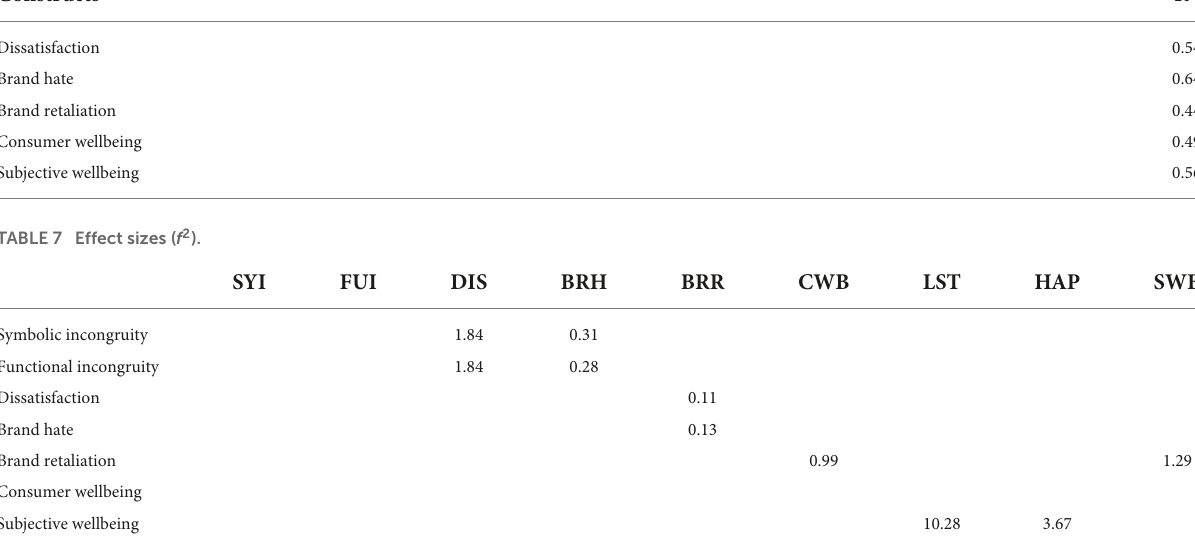
TABLE 7 Effect sizes ( f 2 ).